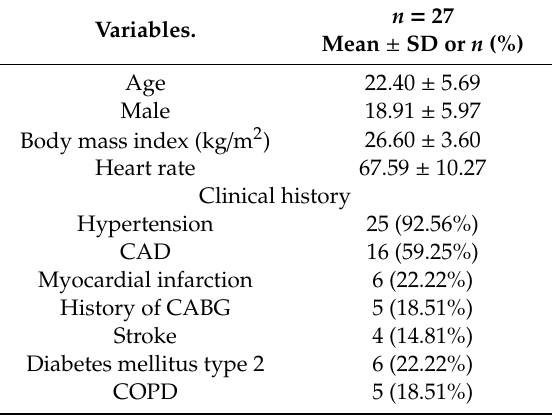
Table 1. Demographic and clinical data of the study population.